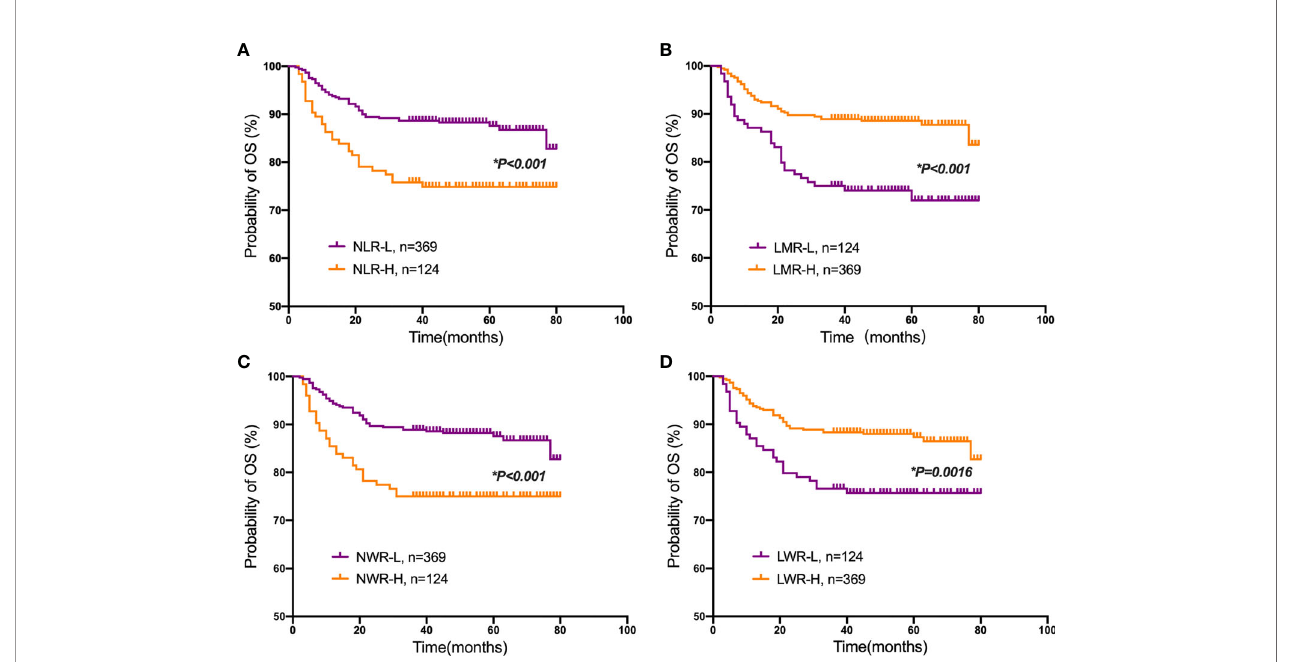
FIGURE 2 | Kaplan-Meier plots for the probability of overall survival (OS). OS rates of the patient subgroups strati fi ed by the (A) neutrophil-to-lymphocyte ratio (NLR), (B) lymphocyte-to-monocyte ratio (LMR), (C) neutrophil-to-white blood cell ratio (NWR) and (D) lymphocyte-to-white blood cell ratio (LWR). Asterisks (*) indicate statistical signi fi cance.